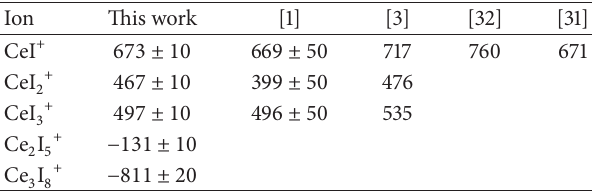
Table 8: Ion formation enthalpies (kJ ⋅ mol −1 ).